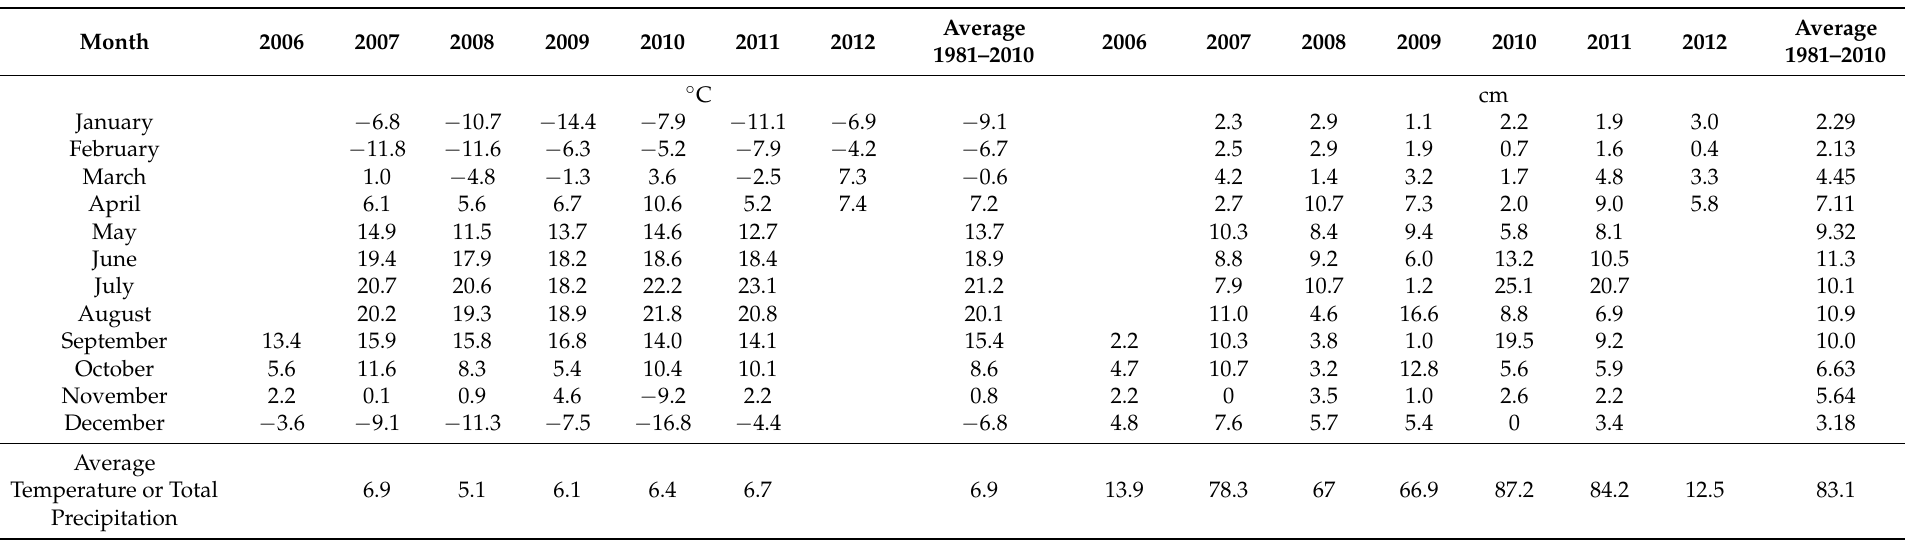
Table 2. Monthly average temperatures ( ◦ C) and precipitation totals (cm) at the Marshfield Agricultural Research Station, Stratford,